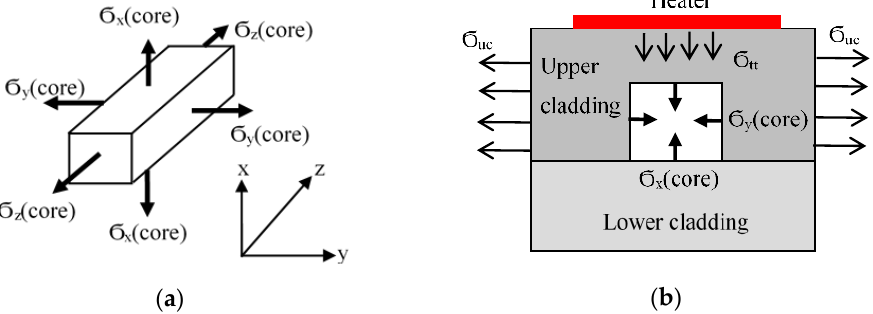
Figure 1. Schematic distribution of the stress field vectors and the thermal field vector for a silica waveguide channel: ( a ) the perspective view; ( b ) the cross-sectional view.